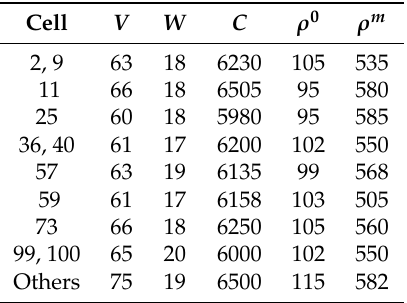
Table 1. Road segment fundamental